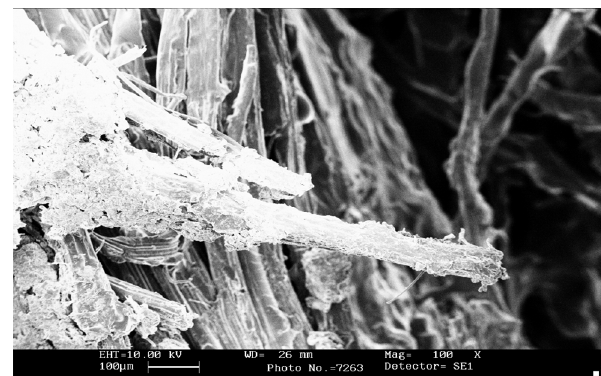
Figure 22: SEM for (10% jute fiber by weight) composite material without coating.